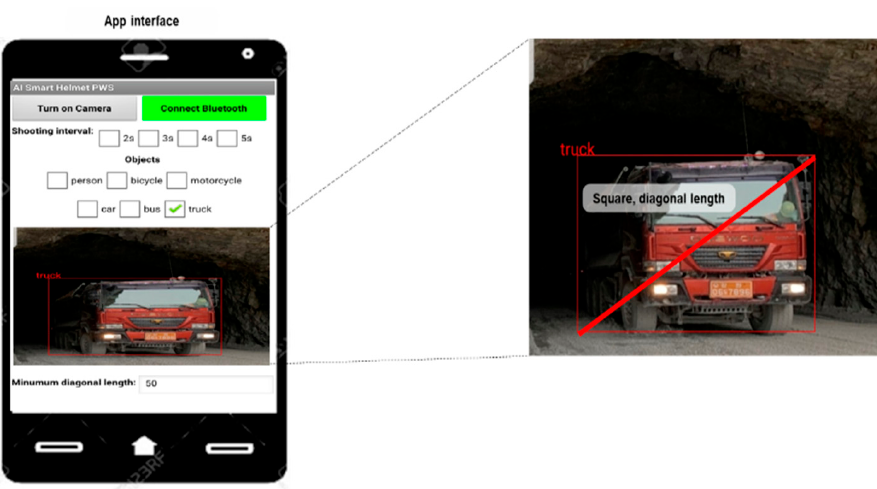
Figure 3. Interface and operating principles of the AI smart helmet PWS.